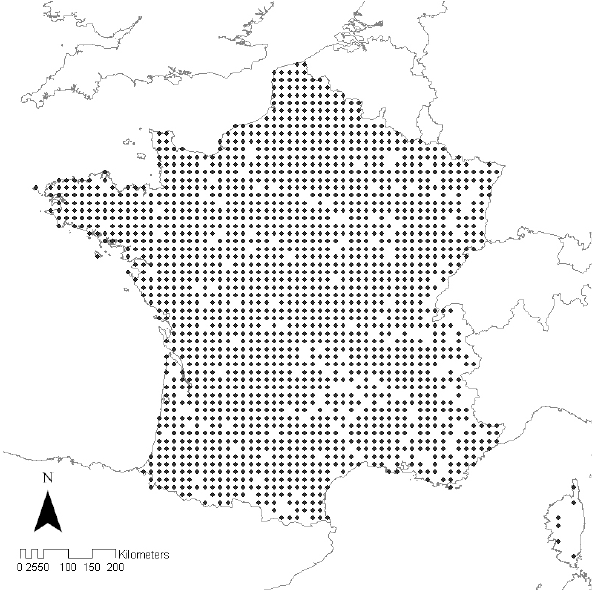
Fig. 1. Distribution of the 1974 sites within the French monitoring network which were used in the present